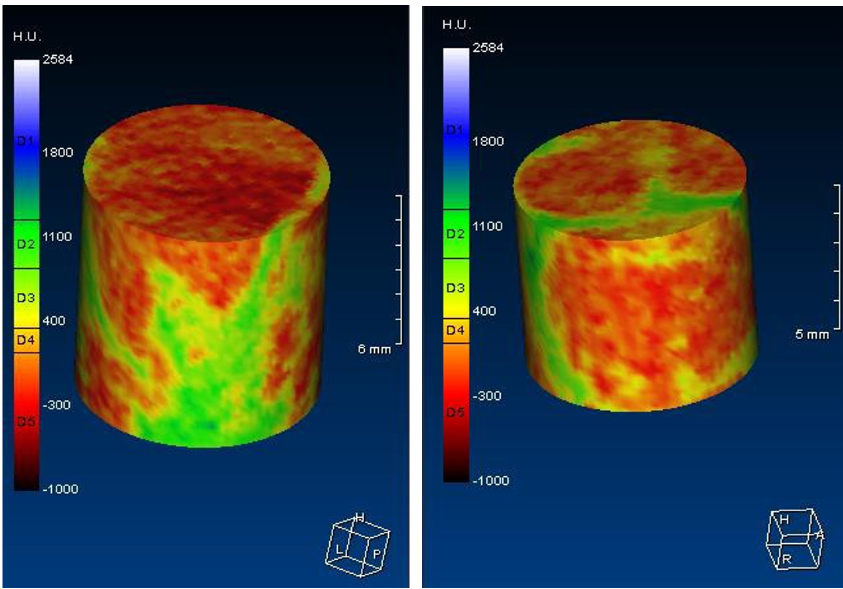
Figure 9. Bone density measurements inside the cavity using a defined implant.